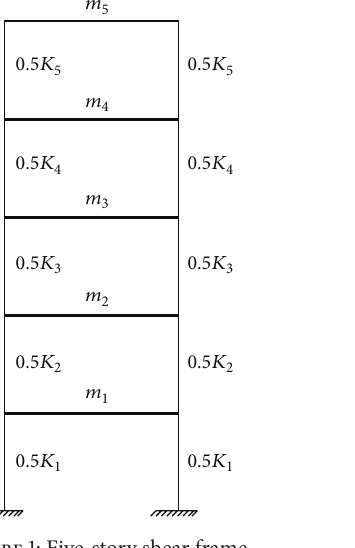
Figure 1: Five-story shear frame. Table 1: The properties of the five-story shear frame. Story number